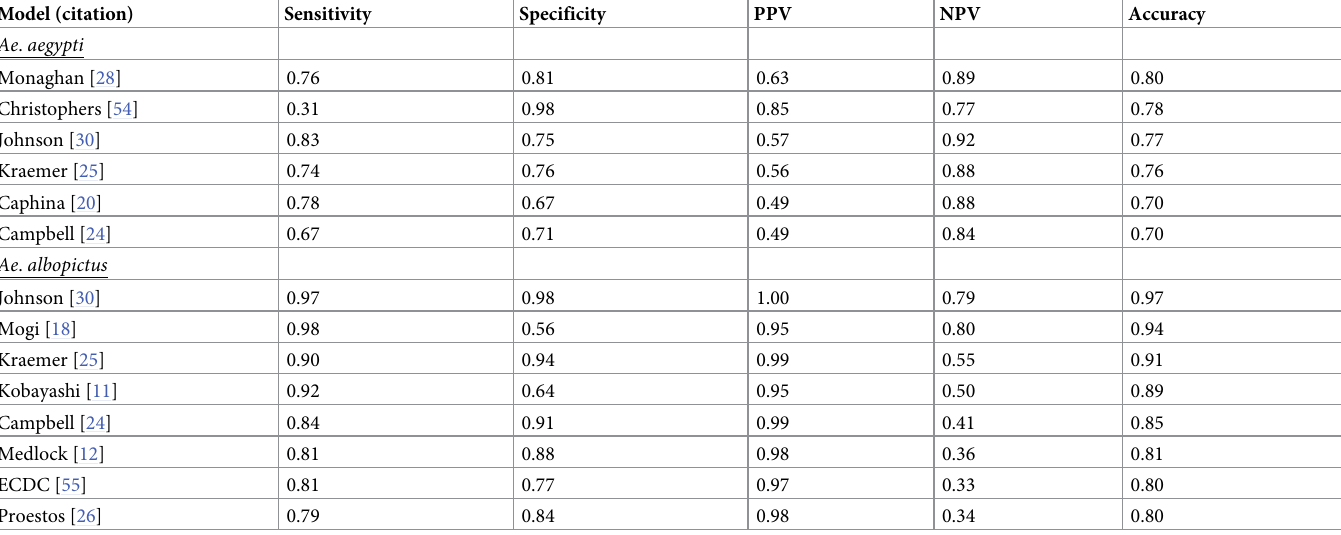
Table 1. Training data fit statistics for the dichotomized base models. Model